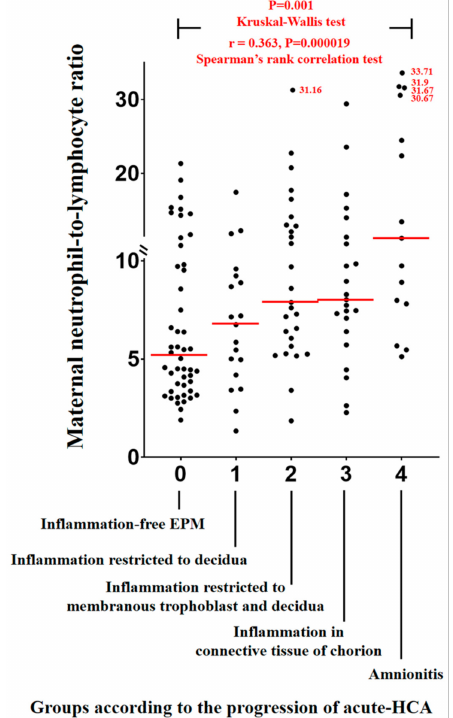
Figure 1. Maternal neutrophil to lymphocyte ratios (NLRs) according to the progression of acute histologic chorioamnionitis (acute-HCA) in extra-placental membranes (EPM). Maternal NLRs significantly and progressively increased with the progression of acute-HCA (group-0 vs. group-1 vs. group-2 vs. group-3 vs. group-4; median, range; 5.15 (1.90–21.30) vs. 6.70 (1.30–17.40) vs.